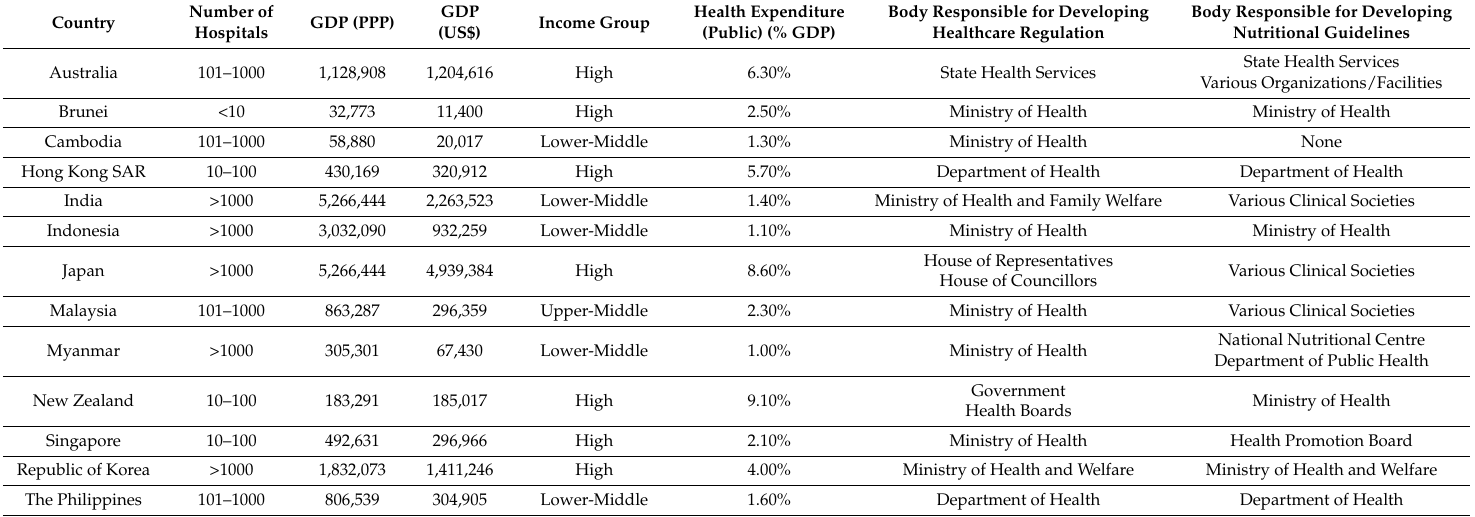
Table 1. Demographics of Countries Participating in Survey.